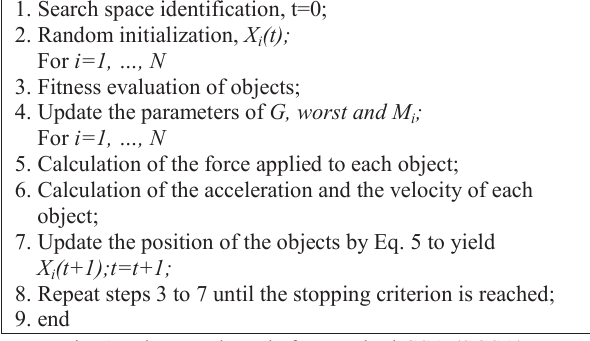
Fig. 1. The pseudo code for standard GSA